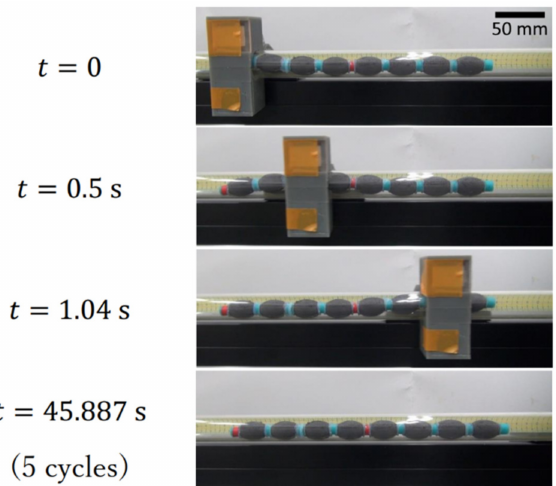
Figure 11. Caterpillar locomotion performed by the fabricated MAE crawling robot. The time for the magnet to move back to its initial position is included in the total time.